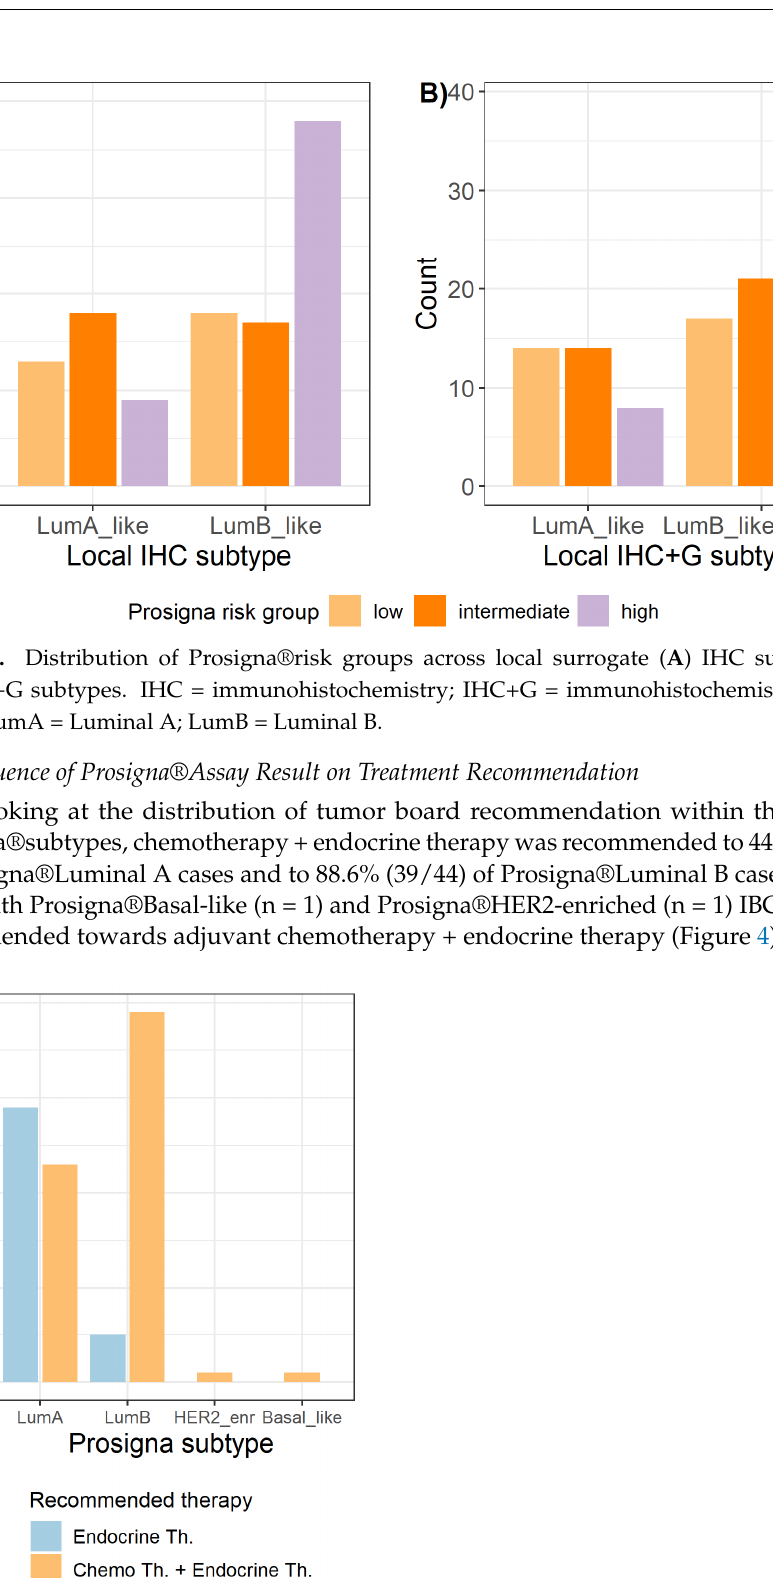
7 of 18 Figure 2. Distribution of Prosigna® subtypes across A) Prosigna® risk of recurrence and B)